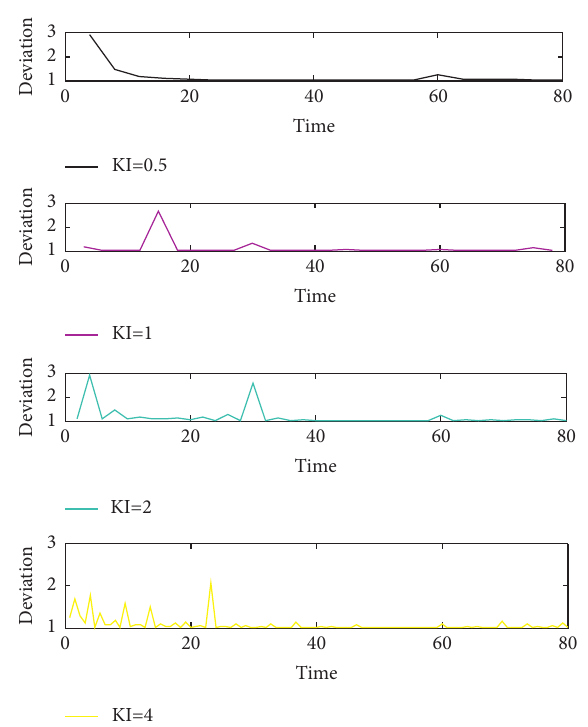
Figure 6: The impact of KI on the transition process (KP � 2, KD � 0).